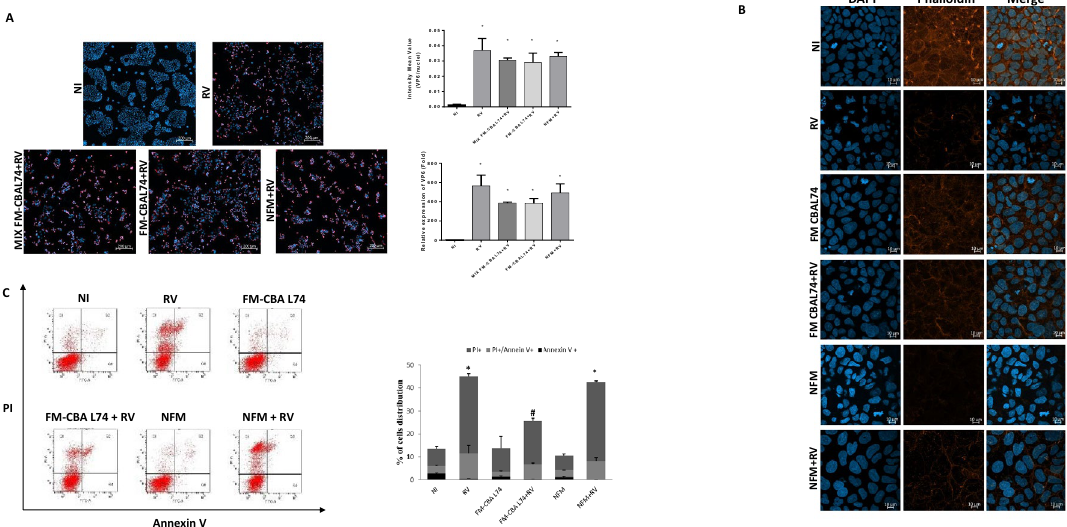
Figure 1. Effects of FM-CBAL74 on cellular damage in Rotavirus- infected human enterocytes. (A) Caco-2 cells were infected with RV and pretreated with FM-CBAL74 or NFM for 48 h. Cells were fixed and processed for immunofluorescence (IF). VP6 protein was visualized with anti-VP6 and Alexa Fluor-594-conjugated secondary antibody (red) and nuclei were stained with DAPI (blue). Cells were observed through confocal. (Left panel) The infectivity of RV in Caco-2 cells was analyzed by the quantification of VP6 protein by immunofluorescence (IF) staining. The addition of FM-CBAL74 to RV for up to 6 h before infection (MIX FM-CBAL74 + RV) or pre-incubation with FM-CBAL74 (FM-CBAL74 + RV) resulted in no significant modulation of RV infectivity. Representative images of IF are reported in the Figure. Scale bar, 200 µm. (Right panel) The quantification (intensity mean value) of VP6 protein is reported in upper graph. An increase of VP6 mRNA levels, evaluated by RT-PCR, was observed in RV-infected enterocytes in below graph. The incubation of RV with FM-CBAL74 for 6 h before infection (MIX FM-CBAL74 + RV) or pre-incubating the cells with FM-CBAL74 for 48 h before RV infection (FM-CBAL74 + RV) were unable to significantly decrease the VP6 mRNA levels. (B) Caco-2 cells were infected with RV and pretreated with FM-CBAL74 or NFM for 48 h. Cells were fixed and processed for immunofluorescence. Actin was visualized using phalloidin-TRITC (red) and nuclei were stained with DAPI (blue). RV-infected enterocytes showed a marked alteration of cytoskeleton structure with a disorganization of F-actin filaments. Disorganized actin in RV-infected cells is shown within yellow squares. Non-infected cells showed a regular distribution of cytoskeleton actin filaments. Pre-incubation with FM-CBAL74 (FM-CBAL74 + RV), but not with NFM (NFM + RV), protected the cells against RV-induced F-actin filaments rearrangements. Representative images of IF are shown in the Figure. Scale bar, 10 µm. (C) Caco-2 cells were infected with RV pretreated with FM-CBAL74 or NFM for 48 h. Apoptotic cell rate was assessed by annexin V assay using flow cytometry. An increase in necrotic cells (positive only for propidium, PI) and late apoptotic cells (positive for both PI and Annexin V) confirmed the pro-apoptotic effect induced by RV infection compared to non-infected cells. Pre-incubation with FM-CBAL74 (FM-CBAL74 + RV), but not with NFM (NFM + RV), prevented these effects. Data represent the means with SD of 3 independent experiments, each performed in triplicate. Data were analyzed using the one-way ANOVA test. *p < 0.05 vs non-infected cells (NI); # p < 0.05 vs RV-infected cells; °p < 0.05 vs NFM + RV. RV Rotavirus, FM-CBAL74 fermented milk L. paracasei CBAL74, NFM not fermented cow